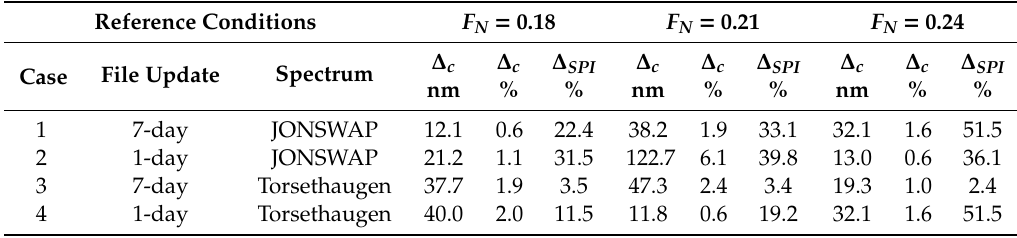
Figure 8. Minimum distance (great circle) and optimal route detection, F N = 0.24: ( a ) Case 1; ( b ) Case 2; ( c ) Case 3; ( d ) Case 4. Table 5. Incidence of vessel speed on optimal route detection.